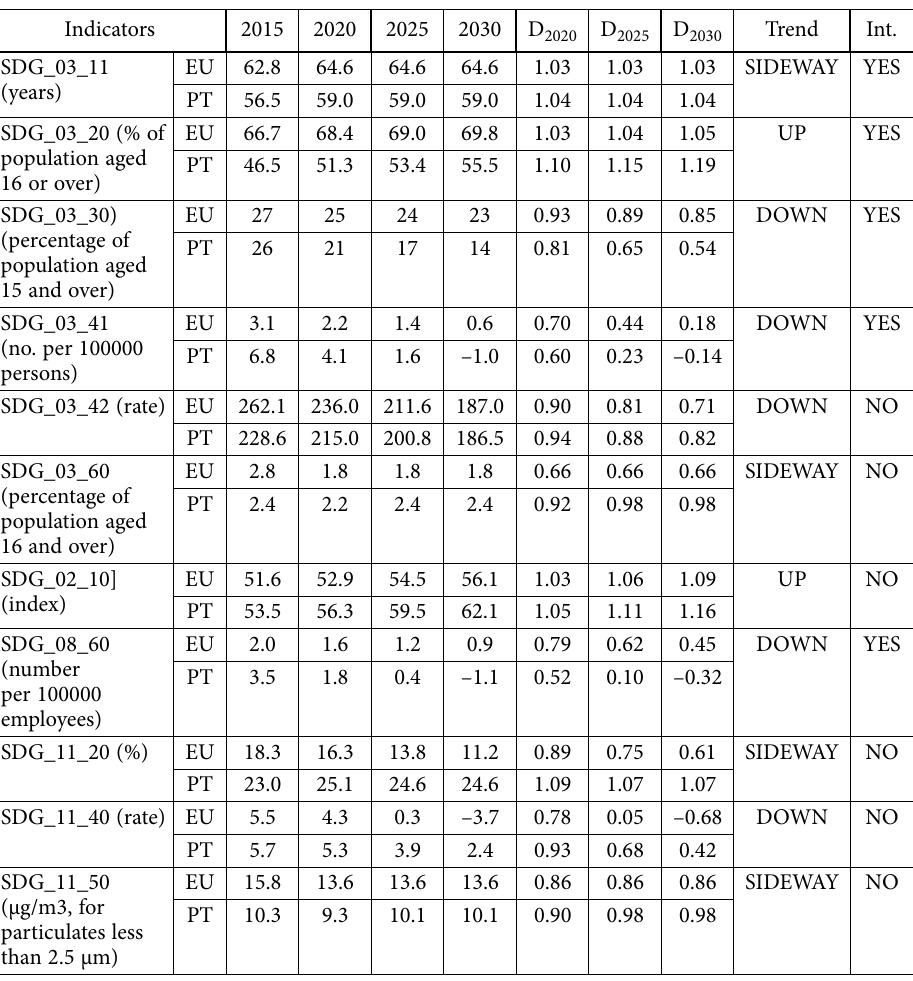
Table 4. SDG 3 – Good health and well-being